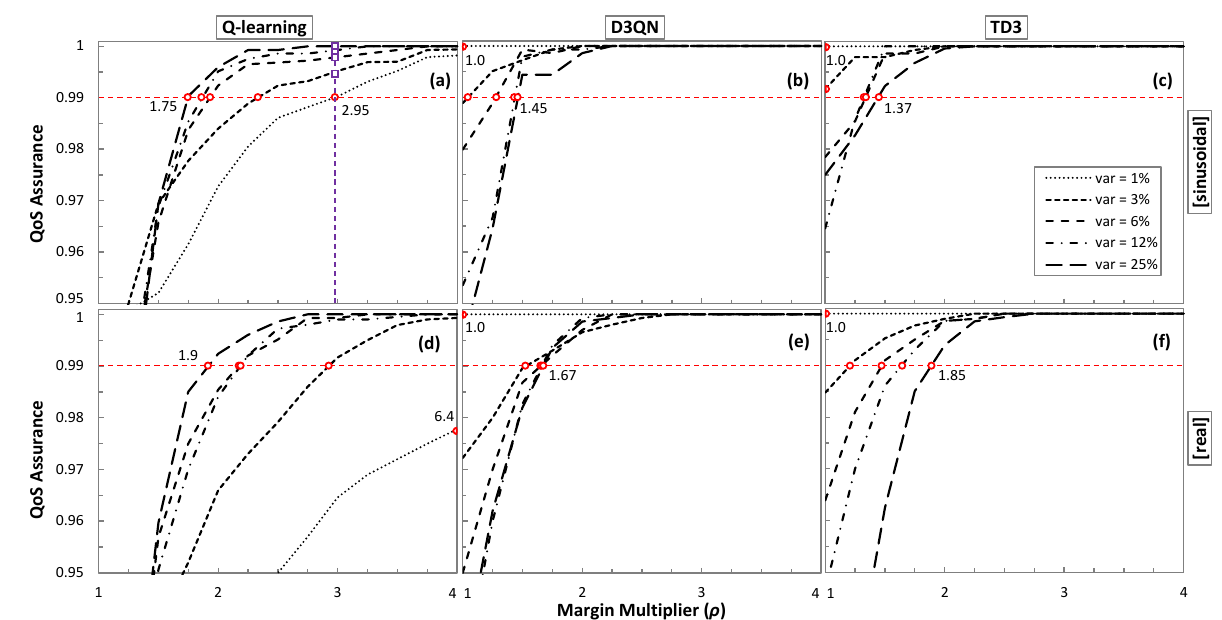
Figure 10 . QoS as a function of ρ models trained with a sinusoidal traffic pattern ( a – c ) and real traffic ( d – f ).